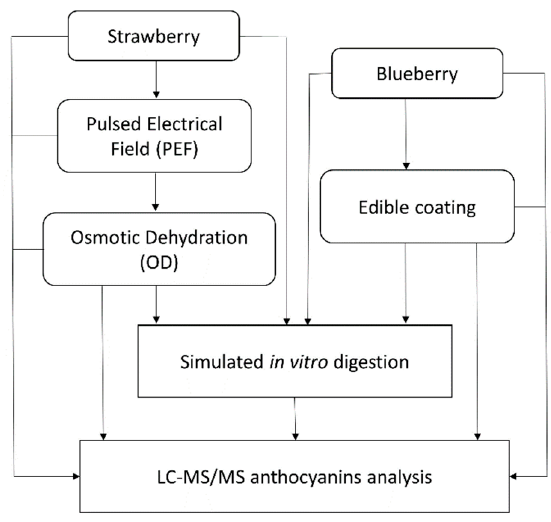
Figure 1. Overview of the materials and methods.